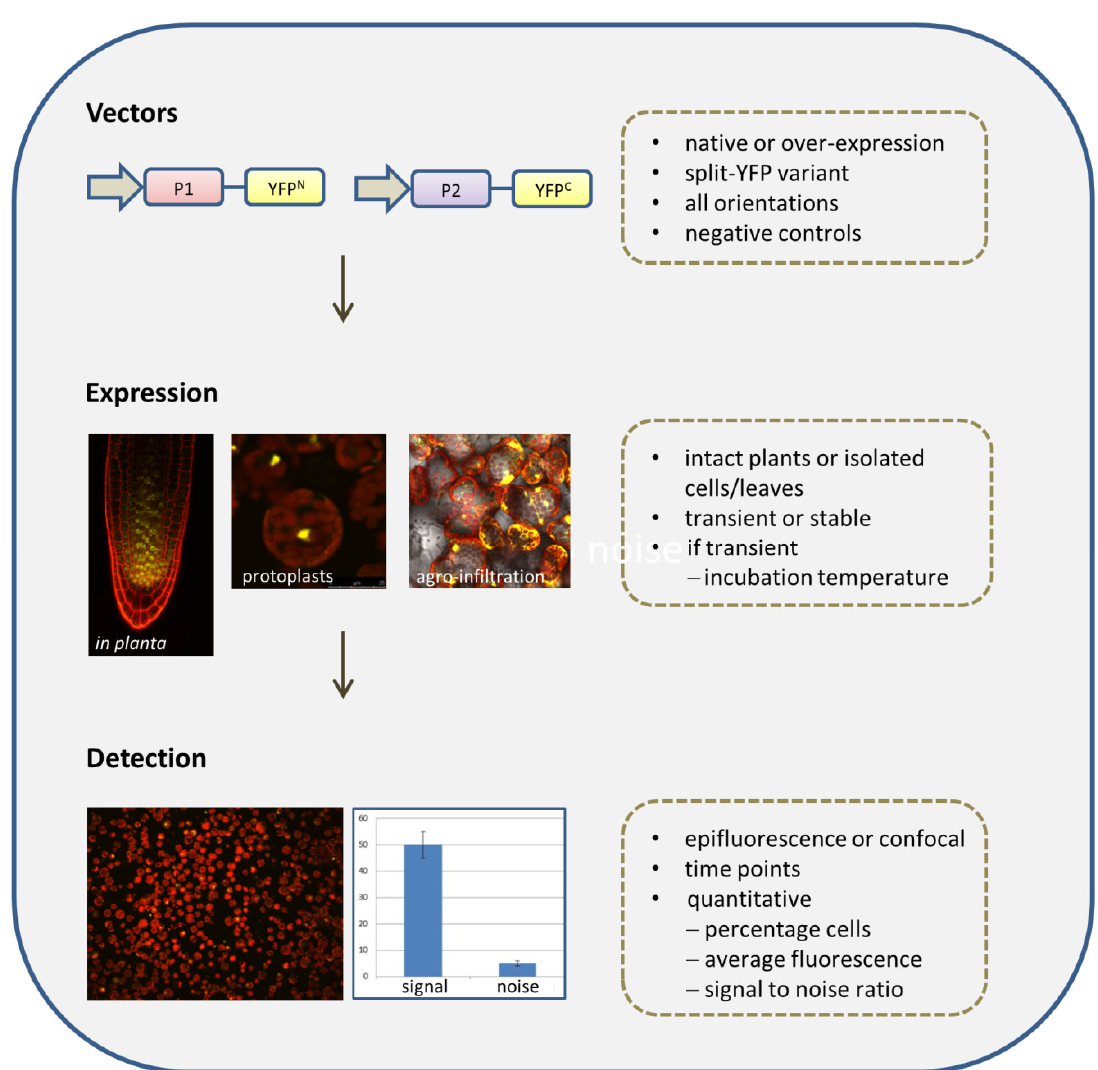
Figure 3. Flow diagram representing the steps and critical points in a BiFC